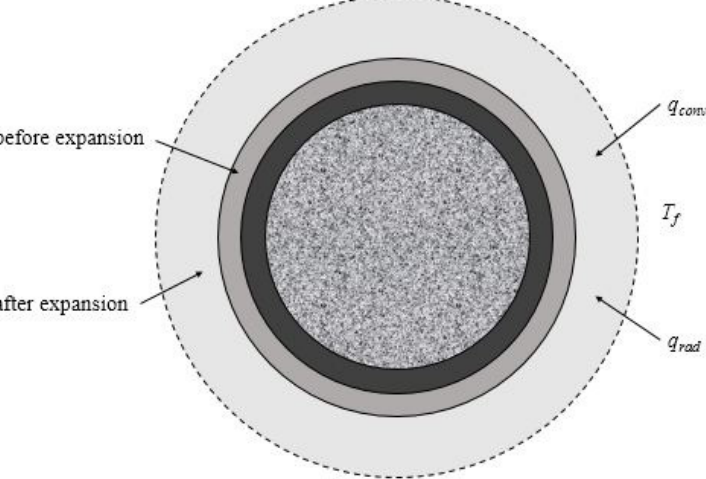
where q , q conv and q rad represent, respectively, the total heat flux, convective heat flux and radiative heat flux.